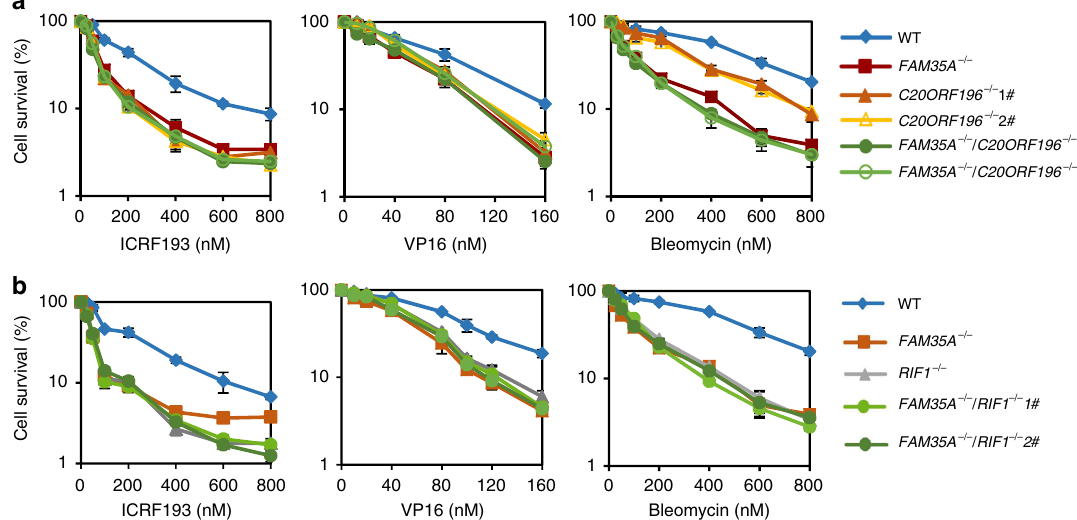
Fig. 4 FAM35A and C20ORF196 are in the same pathway with RIF1 to repair DSB. a , b Genetic interaction analysis of FAM35A with C20ORF196 ( a ) and RIF1 ( b ) in DT40 cells. The mean and s.d. from three independent experiments are